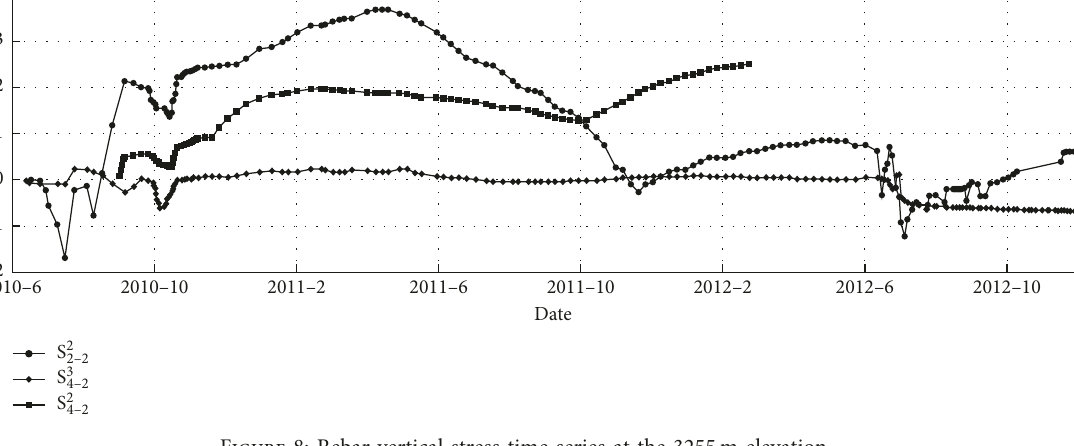
Figure 8: Rebar vertical stress time series at the 3255m elevation.